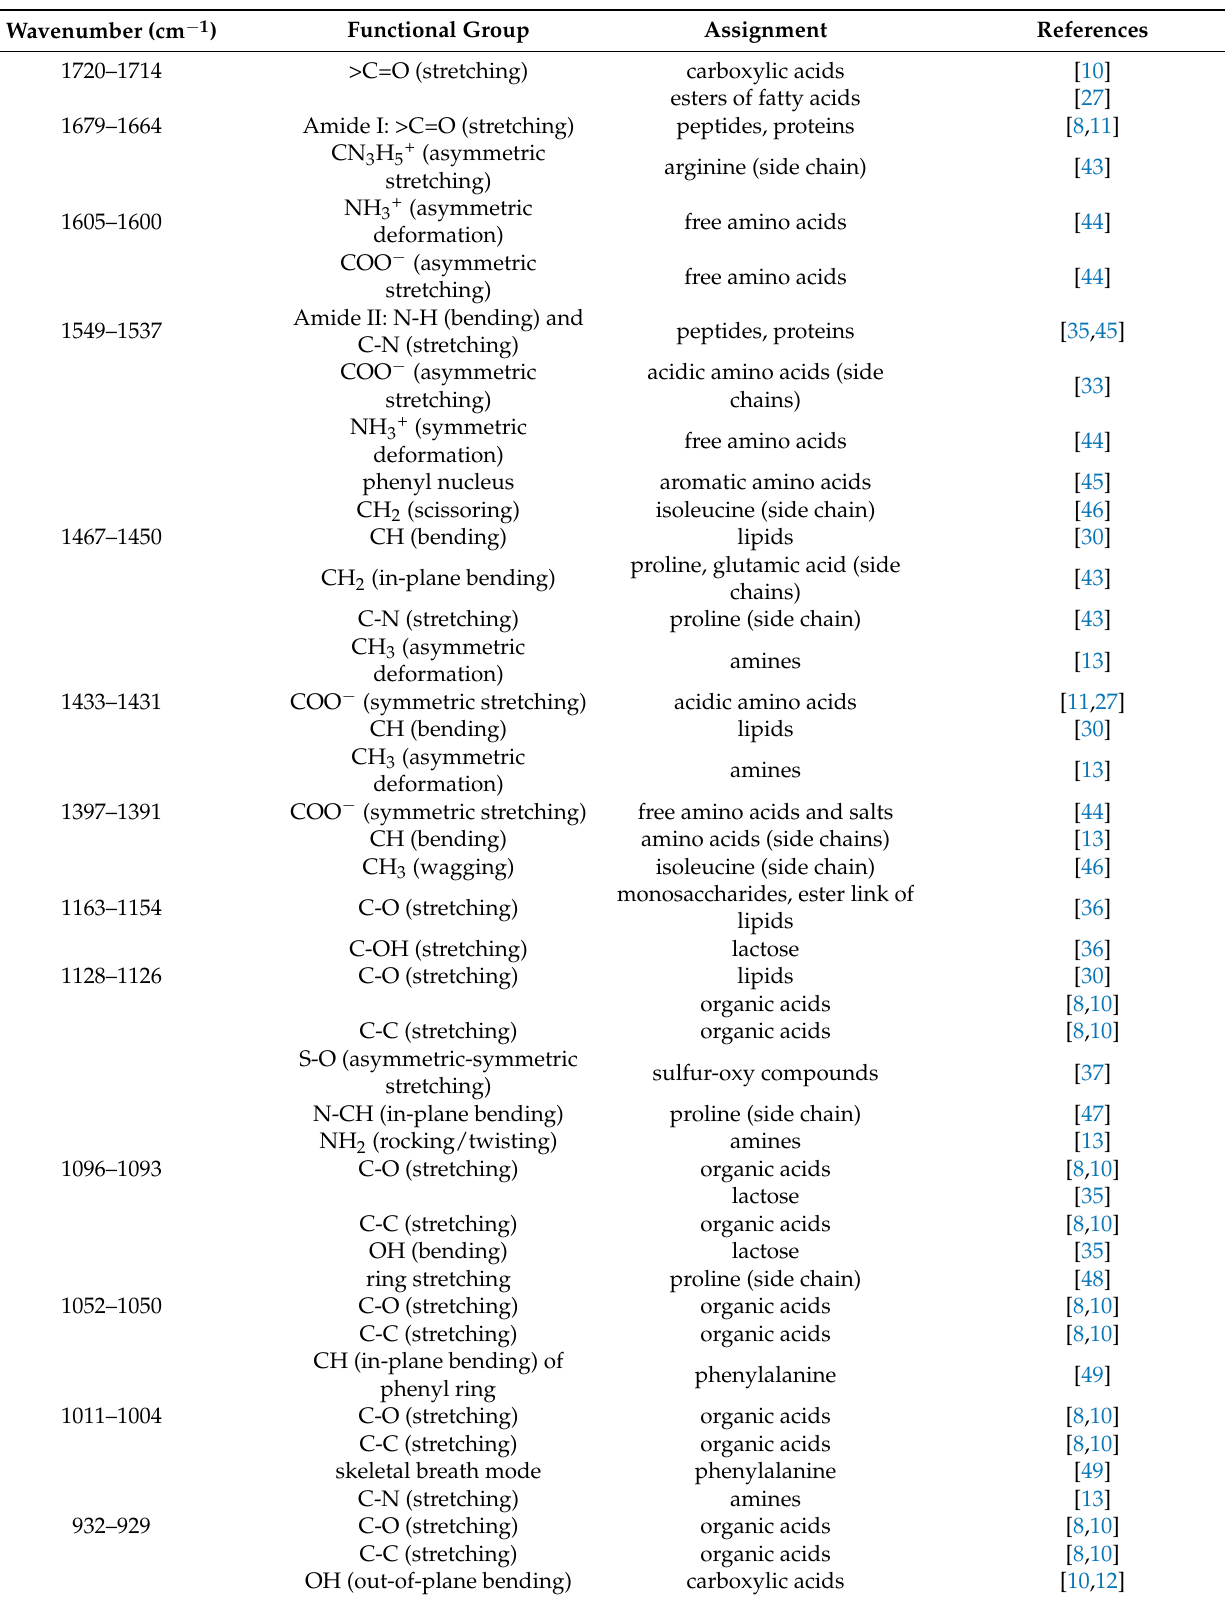
Table 1. Wavenumbers of the 15 peaks distinguished in 1854–1381 and 1192–760 cm − 1 spectral regions of cheese water- soluble extracts and functional groups of the substances that absorb, among others, infrared light in the corresponding peak spectral